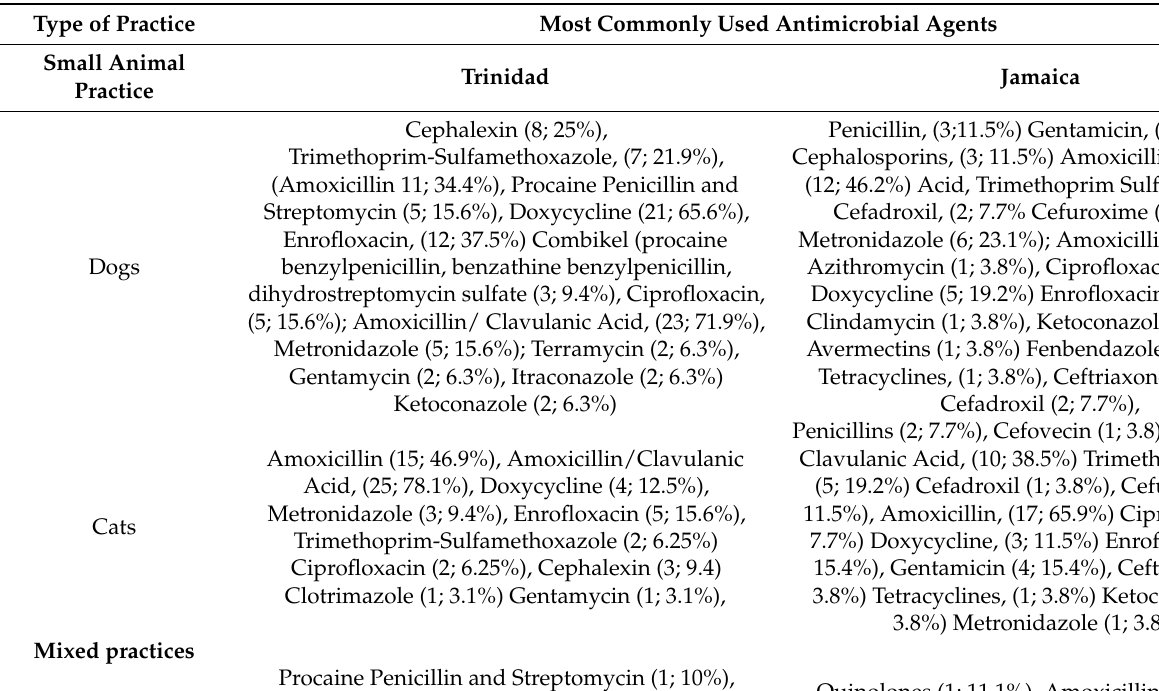
Table 1. Showing the Most commonly used Antimicrobial Agents in Small Animal Clinics and Mixed Animal Practices in Trinidad and